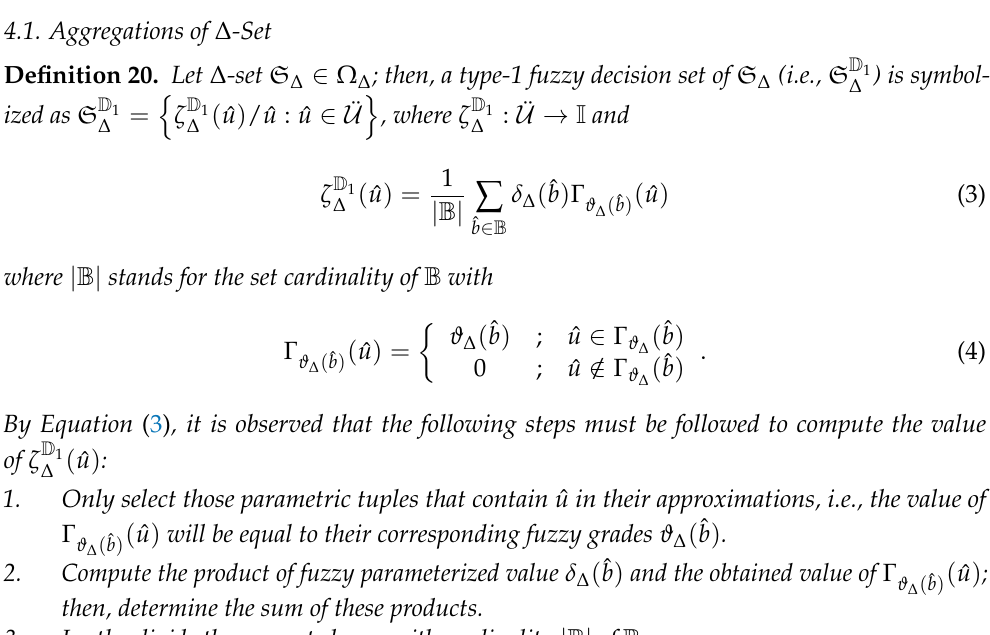
Figure 1. The pictographic demonstration of inclusive